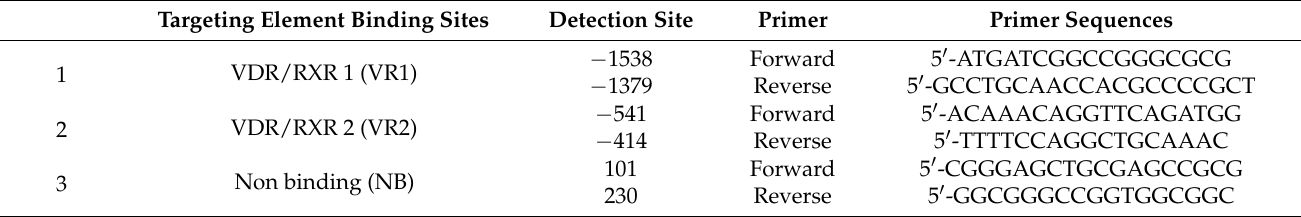
Table A3. The ChIP assay primer information used for detecting binding sequences in this study (Figure 5e,f). Targeting Element Binding